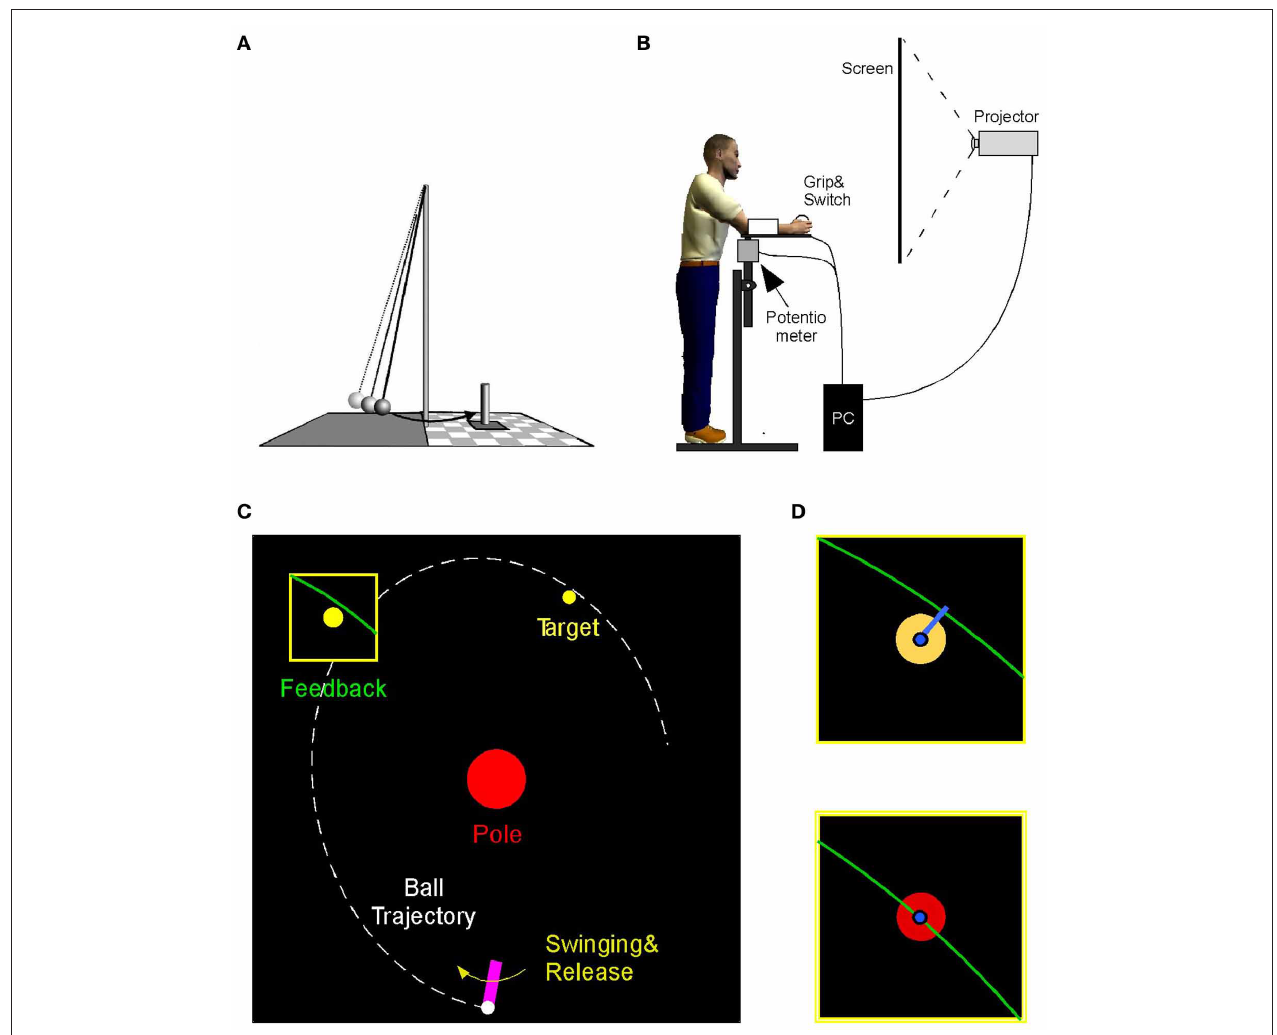
trajectory, the center post, and the target. The task result was defined as the distance between the trajectory and the target skittle, shown after execution in a zoom window. (D) The target color turned red when the distance error was below